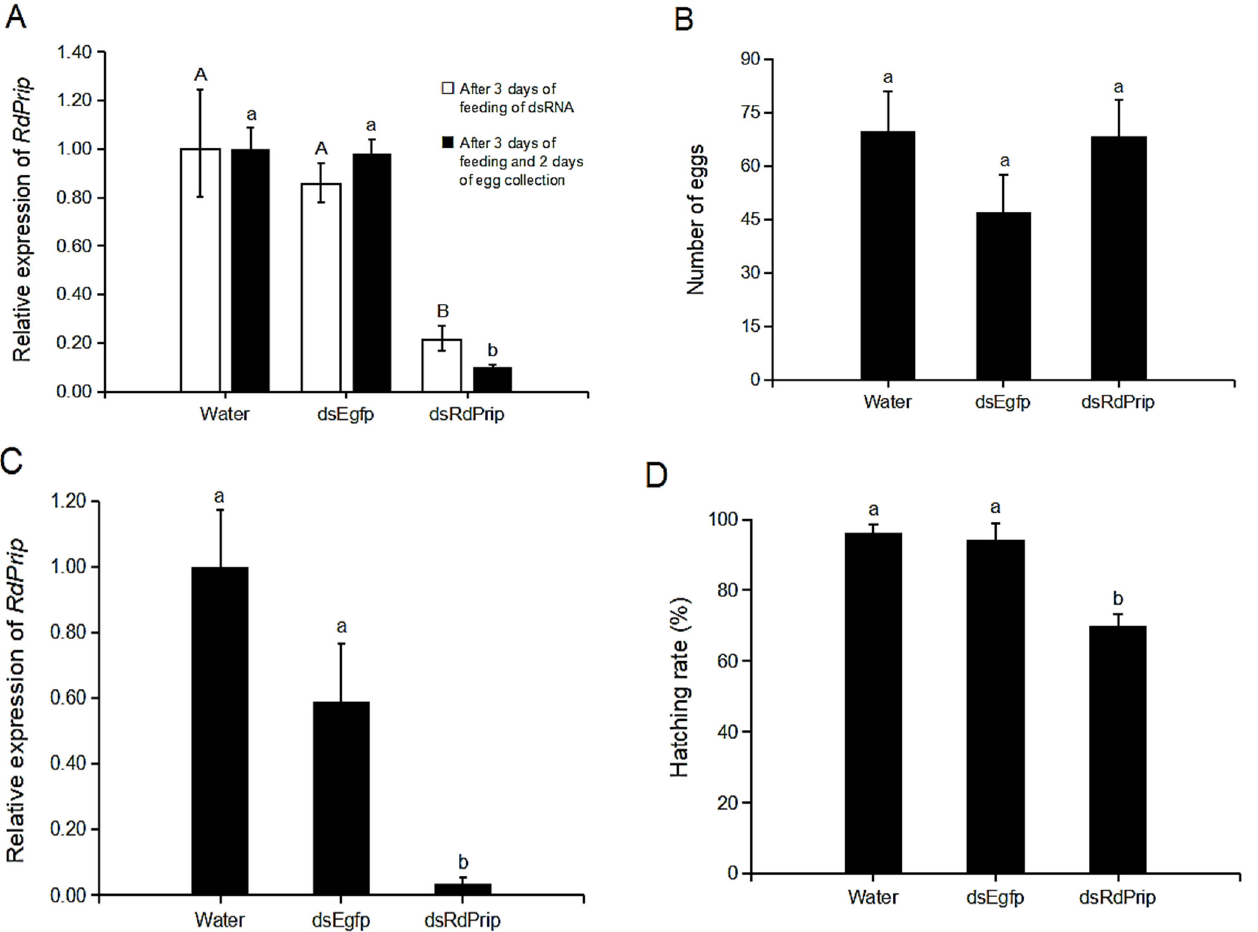
Figure 3. Functional studies of RdPrip on female reproduction. ( A ) The knockdown efficiency of RdPrip mRNA determined using qPCR. The uppercase and lowercase are for the comparisons among open and solid bars, respectively. ( B ) Fecundity of RNAi-treated female adults. ( C ) The transcriptional expression of RdPrip in eggs laid by RNAi-treated female adults. ( D ) The hatching rate of eggs laid by RNAi-treated female adults. The error bar represents the standard error of three replicates. Different letters indicate significant differences between treatments ( p < 0.05).